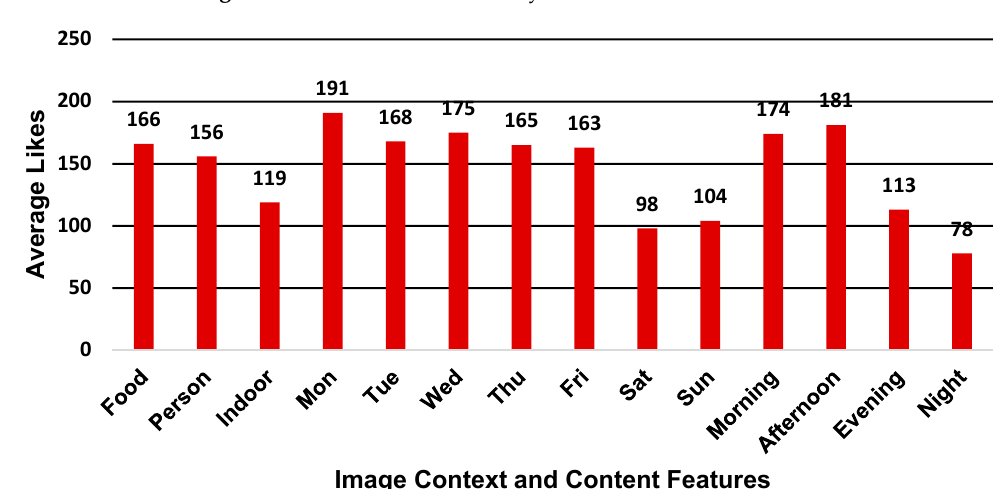
Figure 4. Likes Distribution with Image Context and Content Features.